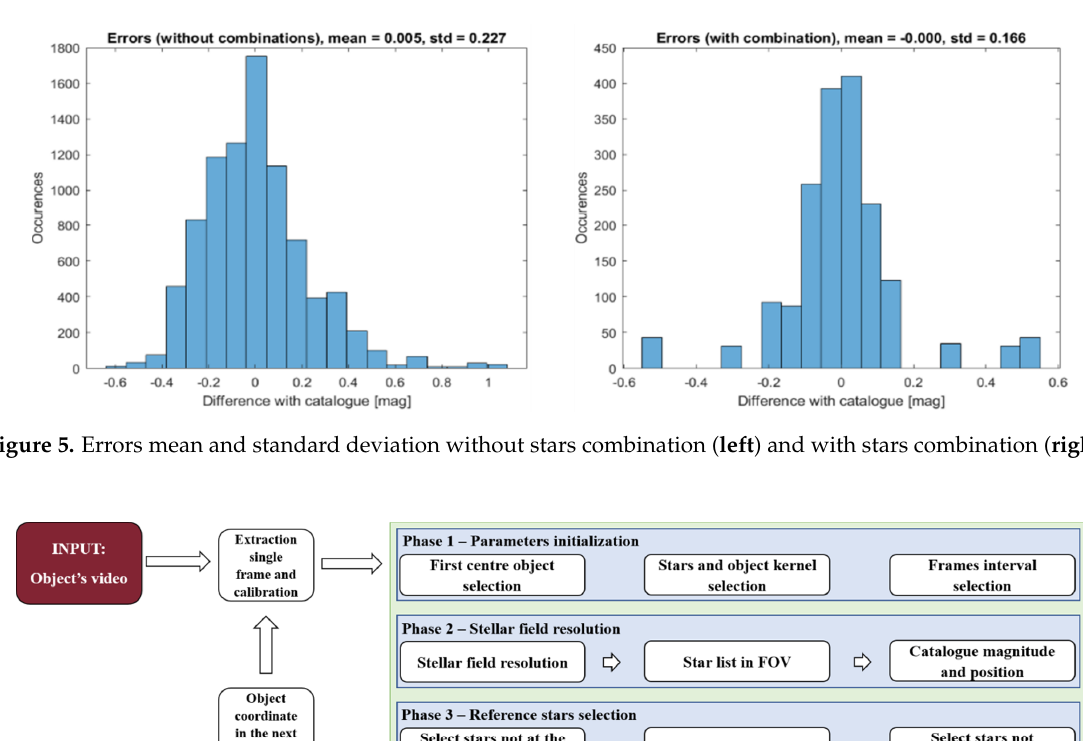
Figure 5. Errors mean and standard deviation without stars combination ( left ) and with stars combination ( right ).